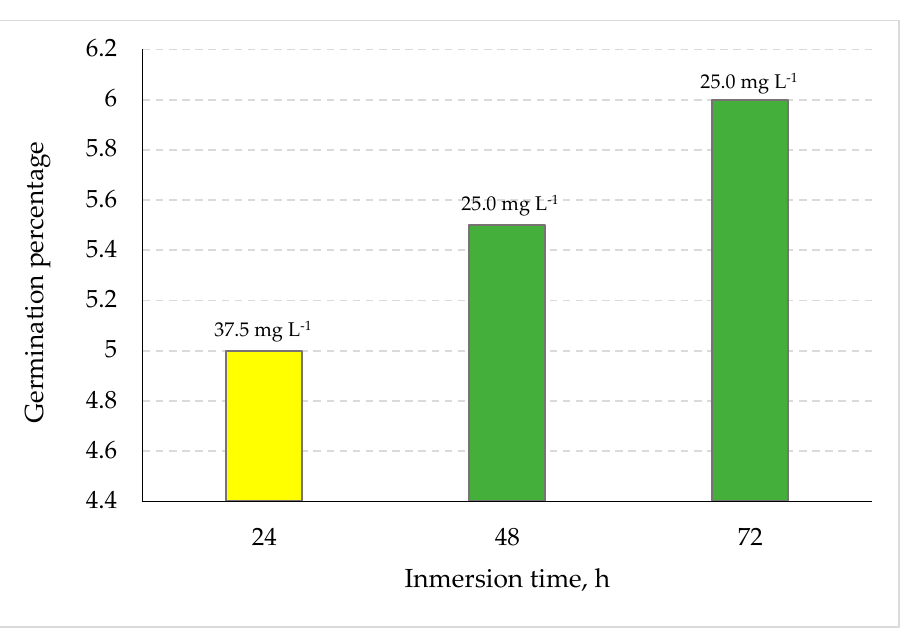
Figure 10. Responses tendency of the germination percentage to Biozyme ® TS (gibberellins) through time, displaying the best dose to reach T 50 . A: Observed tendency; B: Expected tendency. 4. Discussion According to the results of our preliminary experiment on the response of S. edulis to salt concentrations, a notorious seed dormancy was evident. We infer that the primary mechanism observed in S. edulis is attributed to the prevailing physiological condition. In previous studies on the dormancy of the genus, Binet and Boucaud [27] and Capilupo and Ungar [28] found that the species S. maritima and S. depressa have seeds with inherent dormancy. This effect obeys the integument’s physical resistance, associated with low gibberellin levels (Boucaud and Ungar [29]). Other authors mention that mechanically induced dormancy may be associated with reduced hormonal control [30] and that gibberellin is the principal hormone responsible for initiating germination [31].